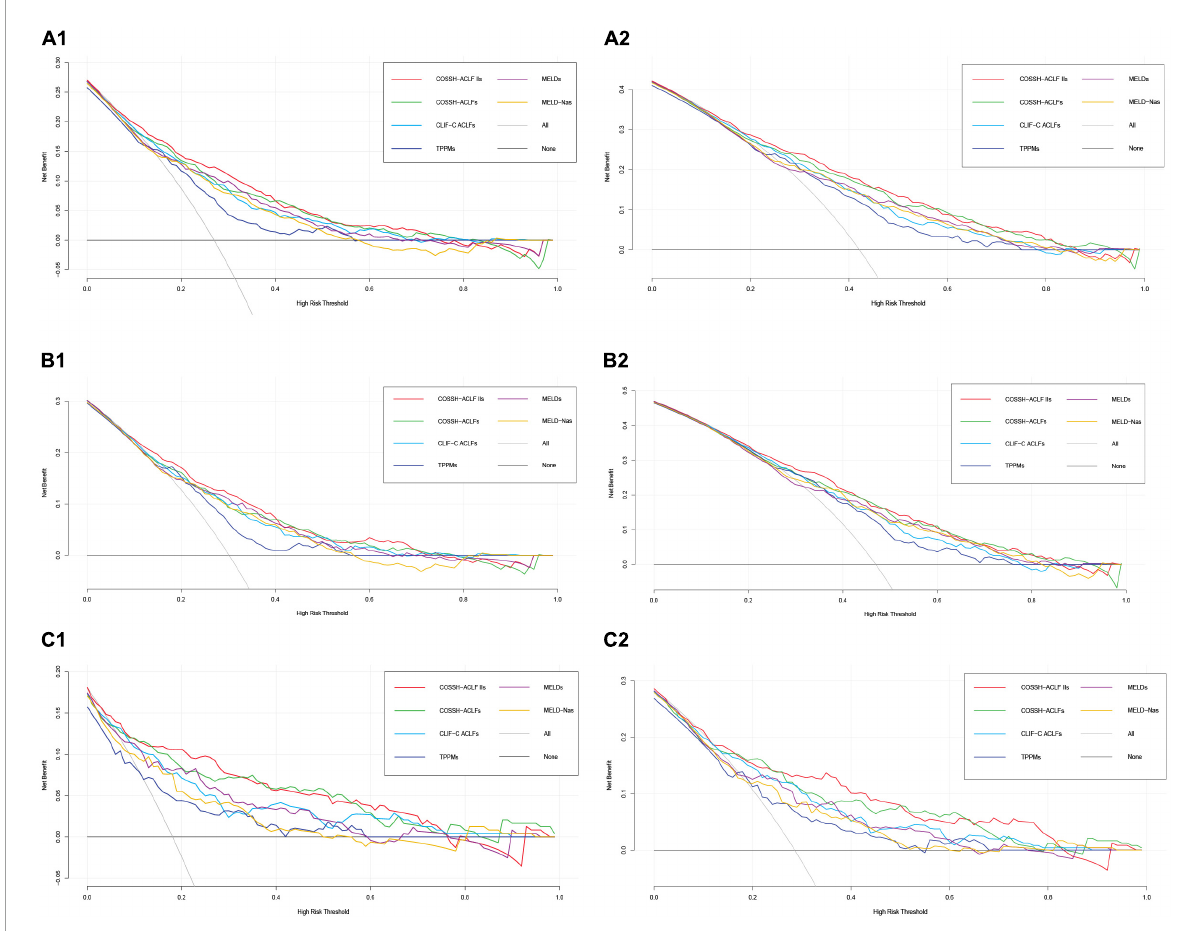
FIGURE4 Decision analysis curve in predicting 28/90-day prognosis of overall patients with HBV-ACLF (A1,A2) , HBV-ACLF patients with cirrhosis (B1,B2) , and HBV-ACLF patients without cirrhosis (C1,C2)